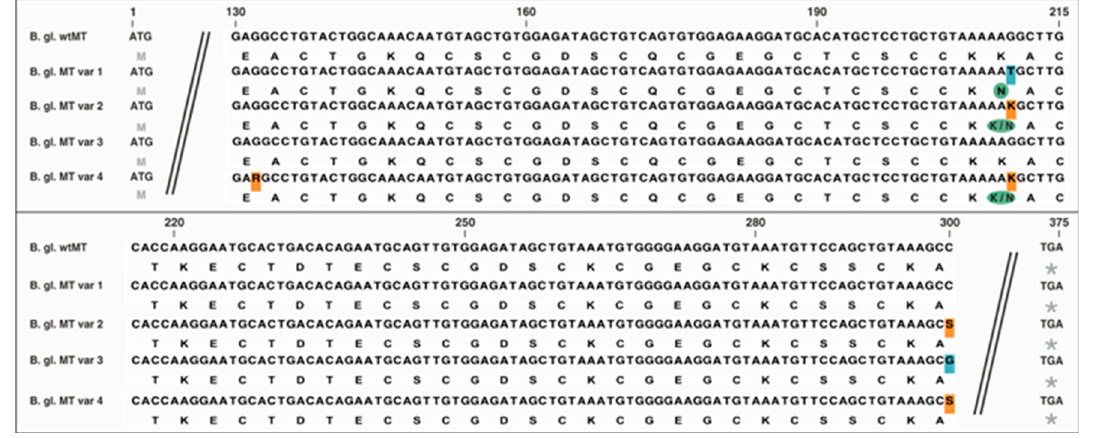
Figure 4. Alignment of the Biomphalaria glabrata wild-type MT (B. gl. wtMT) and its four allelic variants (B. gl. MT var 1–4). Parts of the sequence showing 100% coverage amongst all MTs were cut (two black lines). Nucleotide positions are indexed above the top sequence. Amino acids are displayed in single letter code underneath the respective base triplets and the start and stop codons are marked in grey. Nucleotide mutations are shaded in blue, single nucleotide polymorphisms (SNPs) are shaded in orange and the respective changes of amino acids are indicated by a green circle or ellipses. B. gl. MT var 1 shows a change at position 210 (G is replaced by T—changing the codon from lysine to asparagine). B. gl. MT var 2 shows SNPs at positions 210 (K: represents G or T-changing the codon to either lysine or asparagine) and 300 (S: represents G or C). B. gl. MT var 3 shows a shift at position 300 (C is replaced by G). B. gl. MT var 4 shows SNPs at positions 133 (R: represents A or G), 210 (K: represents G or T—changing the codon to either lysine or asparagine) and 300 (S: represents G or C).